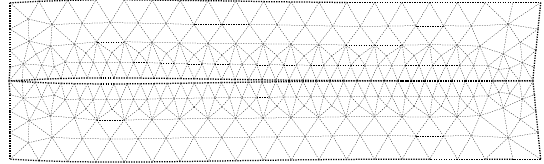
Figure 6.4 . Deformed configuration of the two viscoelastic bodies for µ = 0 . 25ns/m 2 and η = 0 . 15ns/m 2 .